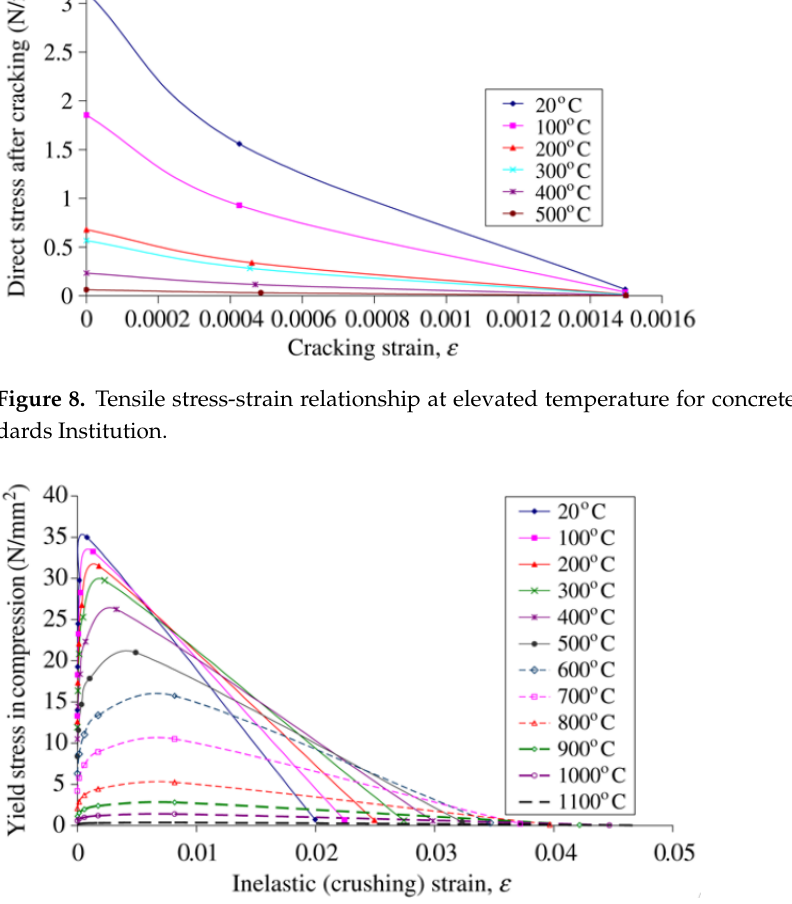
Figure 9. Compressive stress – strain relationship at elevated temperature for concrete, EC2 British Standards Institution.